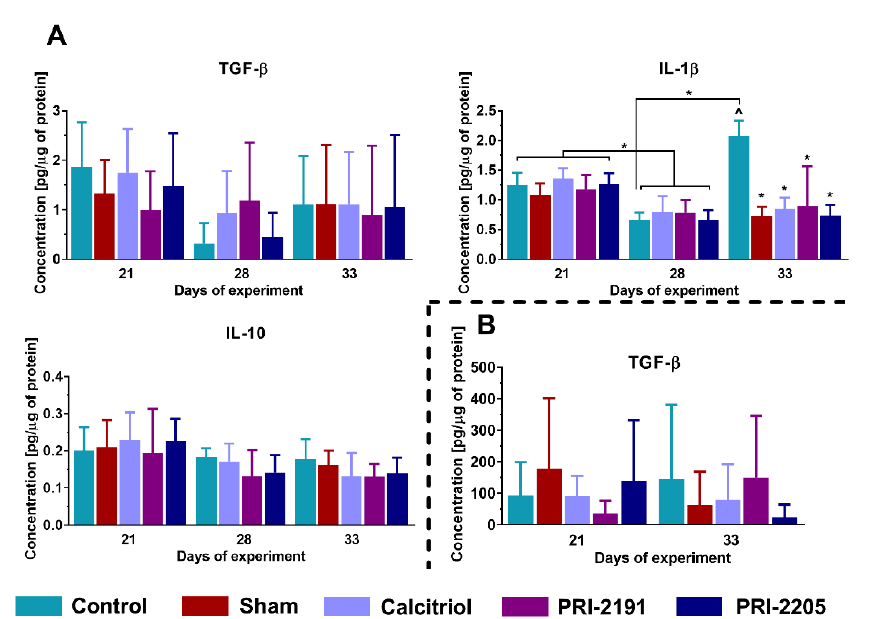
Figure 7. Changes related to protein expression in 4T1 tumor-bearing aged OVX mice. Expression of selected proteins in ( A ) tumor tissue or ( B ) plasma of aged OVX mice measured using ELISA assays. The analysis was performed on samples harvested at days 21, 28, and 33. Briefly, 60-week-old mice were subjected to ovariectomy or sham surgery. After 4 weeks, 4T1 cells were inoculated (day 0) orthotopically and the subcutaneous administration of tested compounds (three times a week) was initiated on day 7 at the following doses: calcitriol, 0.5 µg/kg; PRI-2191, 1.0 µg/kg; and PRI-2205, 10.0 µg/kg. The number of mice analyzed was 3–7 per group. Data presentation: mean with standard deviation (SD). Statistical analysis: Kruskal–Wallis multiple comparison test. * p < 0.05 as compared to control animals or ^ p < 0.05 as compared do control sham animals on the relevant day of treatment or as indicated. IL-1β—interleukin 1β; IL-10—interleukin 10; TGF-β—transforming growth factor β. 2.8. Diversified Effect of Vitamin D Compounds on CCL2 and OPN Secretion by Murine Fibroblasts